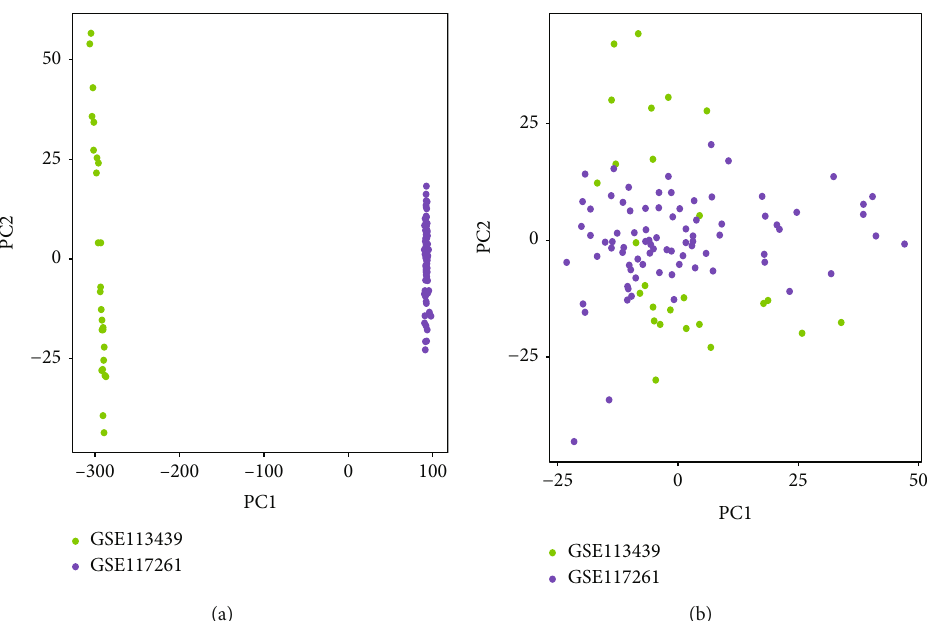
Figure 2: Principal component analysis (PCA) analysis of gene expression datasets. The scatter plots ’ points depict samples based on the top two principal components (PC1 and PC2) of gene expression pro fi les without and with batch e ff ect removal. (a) PCA cluster plot of GSE113439 and GSE117261 before sample correction and batch e ff ect removal. (b) PCA cluster plot of GSE113439 and GSE117261 after sample correction and batch e ff ect removal. The colors denote samples from two distinct datasets, respectively. Each dot represents a sample; green represents a sample from GSE113439; purple represents a sample from